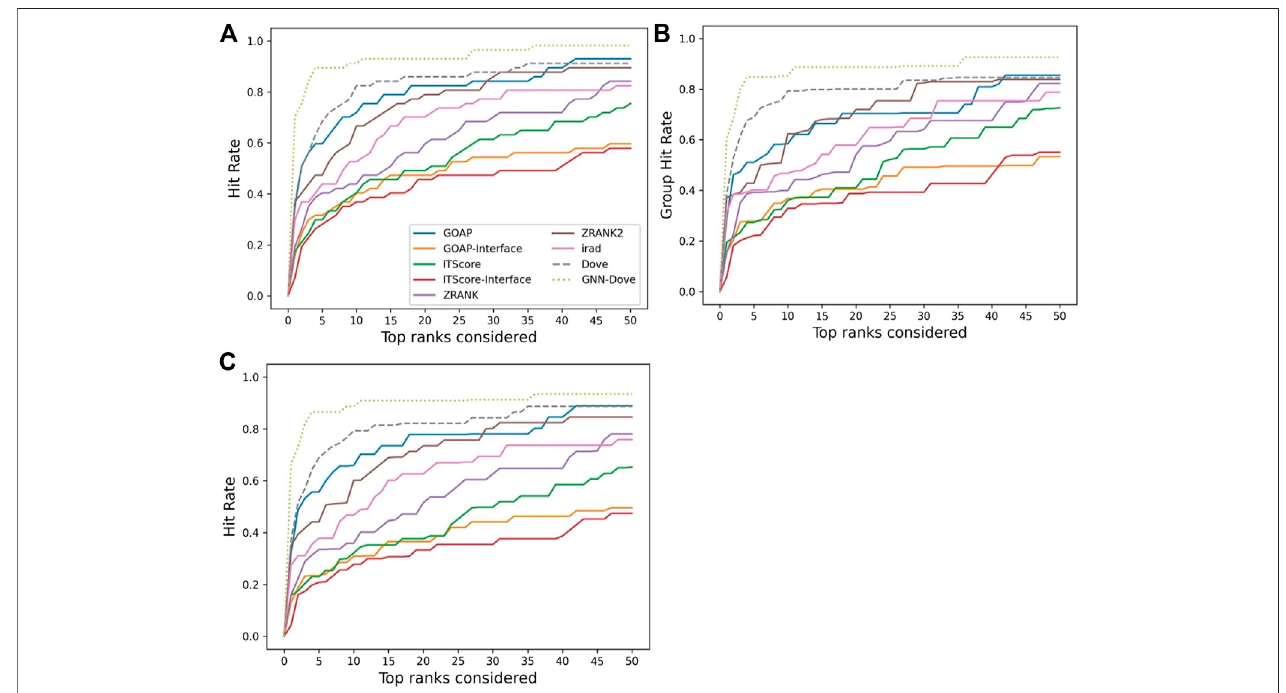
FIGURE2 | Performance on the Dockground dataset. GNN-DOVE wascomparedwithDOVE and seven other scoring methods. (A) The panel shows the fraction of target complexes among the 58 complexes in the benchmark set for which a method selected at least one acceptable model (within top x scored models). (B) Consideringthecomplexesaregroupedinto29groups,wealsocomparedthehitrateofdifferentmethodsbasedonthegroupclassi fi cation.Thehitratesforcomplexes in each group were averaged and then re-averaged over the 29 groups. (C) Results when 46 complex groups were considered that were formed with interface similarity. The hit rates for complexes in each group were averaged and then re-averaged over the 46